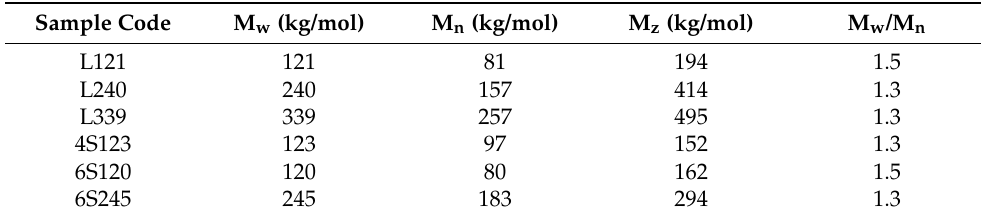
Table 1. The average molar masses, number, M n , weight, M w , and z-average, M z , and dispersity M w/ M n of star and linear